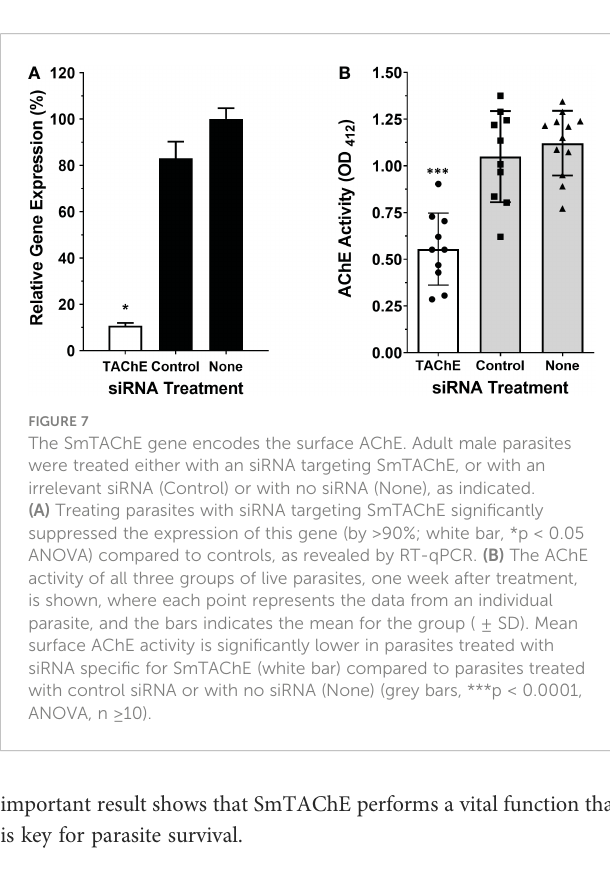
important result shows that SmTAChE performs a vital function that is key for parasite survival.